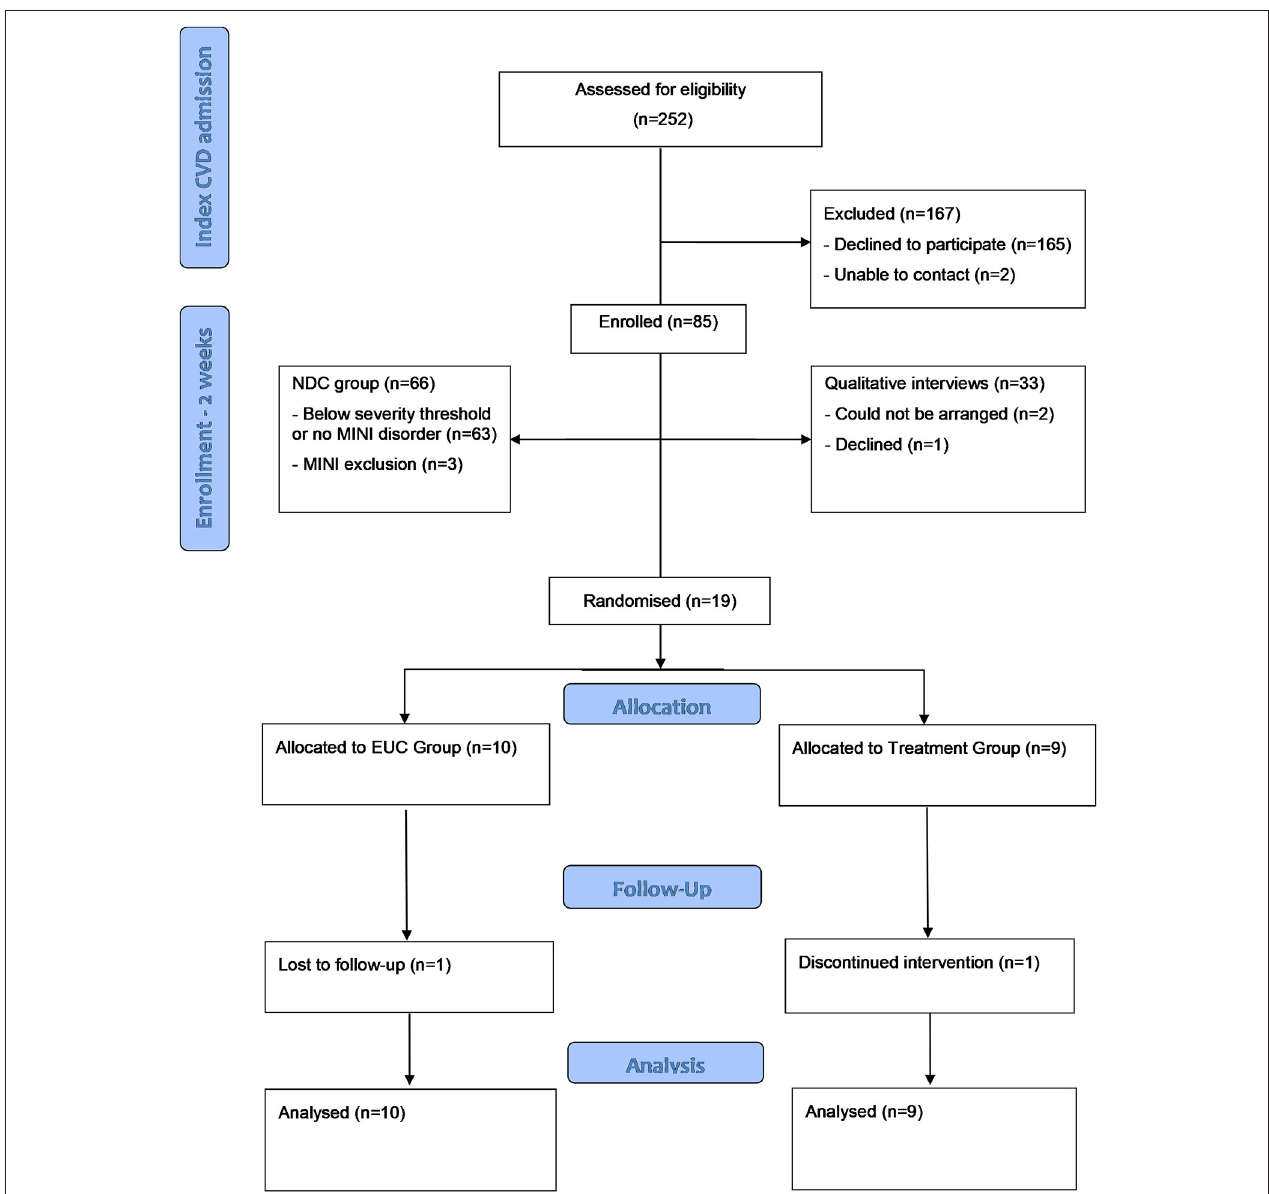
FIGURE 1 | Flow chart of CHAMPS participants through the study. CVD, cardiovascular disease; CHAMPS, Cardiovascular health in Anxiety or Mood Problems Study; EUC, enhanced usual care; GAD-7, generalized anxiety disorder-7; MINI, MINI international Neuropsychiatric Interview; NDC, non-distressed control; PHQ, Patient Health Questionnaire; UP, unified